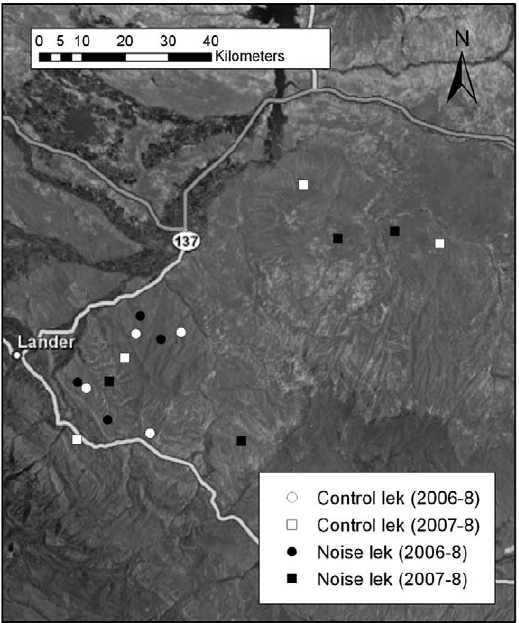
Figure 1. Noise playback study area in Fremont County, Wyoming, USA, 2006–2009. Experimental and control leks were paired on the basis of size and geographic location (the four leks in the upper right are part of the Riverton region, whereas the rest of the leks are in the Lander region).